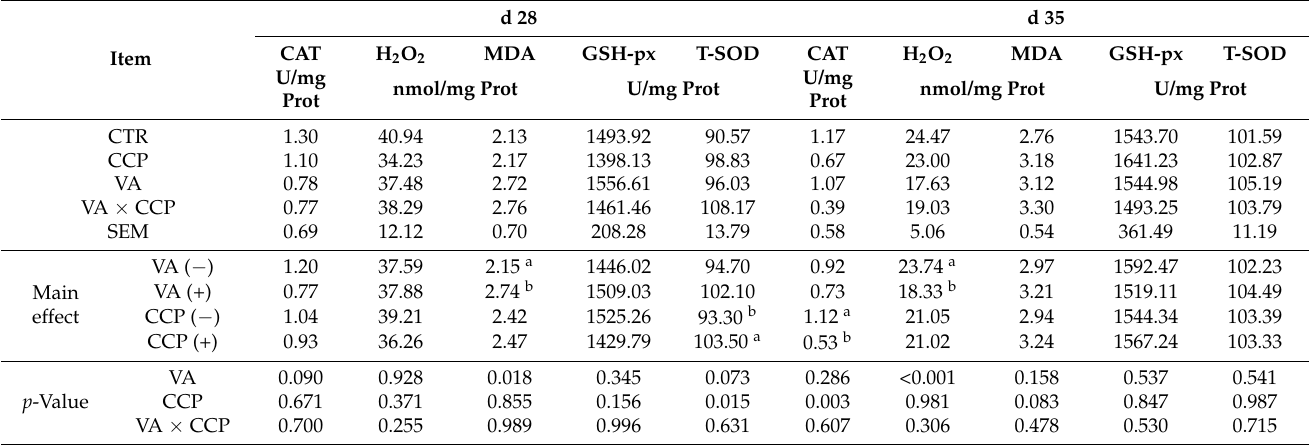
Table 4. Effect of vitamin A on the levels of antioxidant enzymes and peroxidation products in the serum of CCP-challenged broilers.